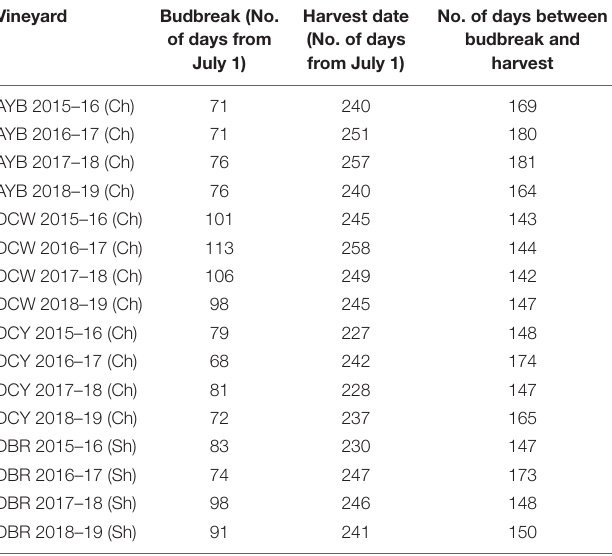
TABLE 3 | Budbreak and maturity (harvest) dates in number of days from July 1 and number of days between both stages. Ch = Chardonnay, Sh = Shiraz. Vineyard Budbreak (No. of days